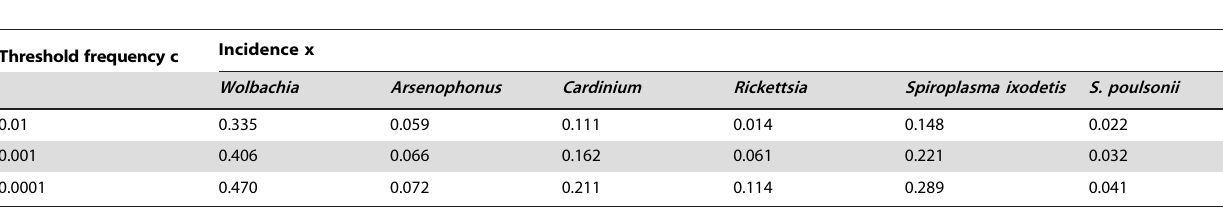
Table 1 . Estimates of incidence x of different endosymbionts, depending on threshold infection frequency c